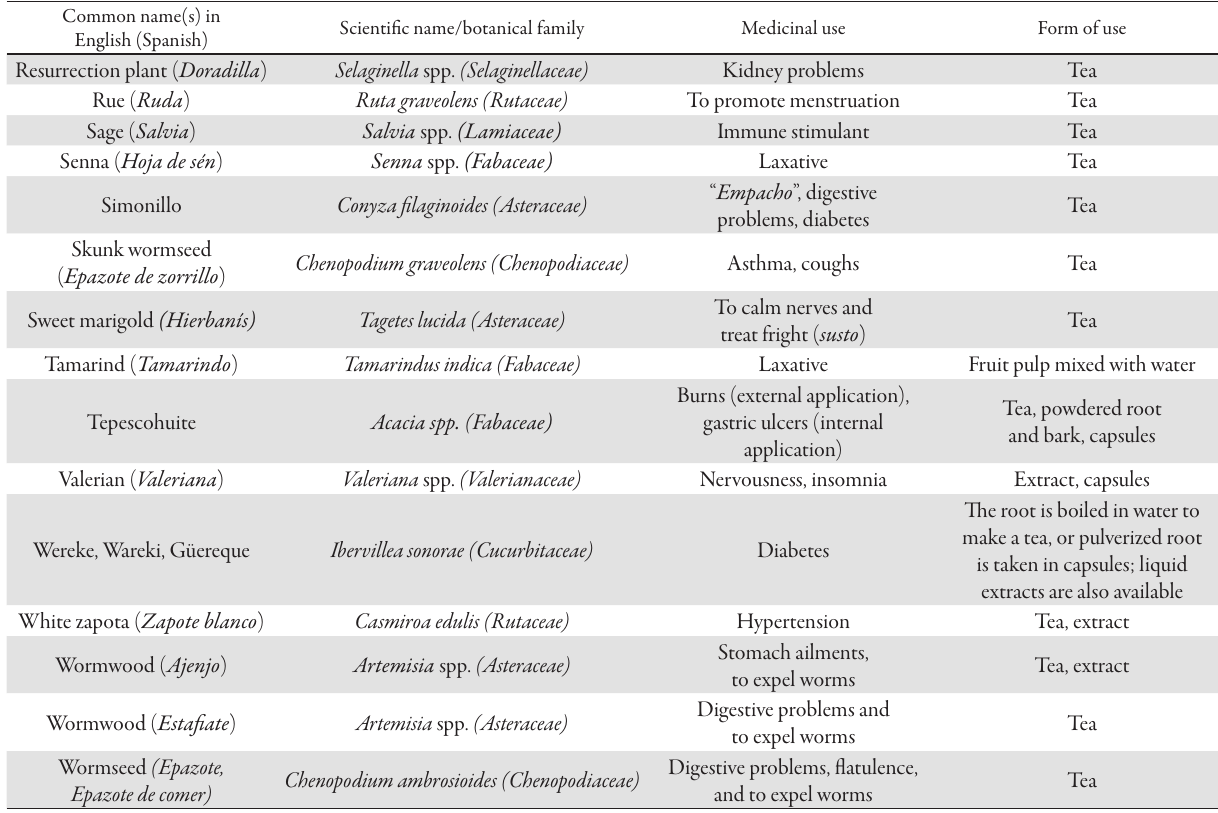
Tab. 1. Medicinal plants used to treat diverse ailments in Monterrey (Continuous) Common name(s) in English